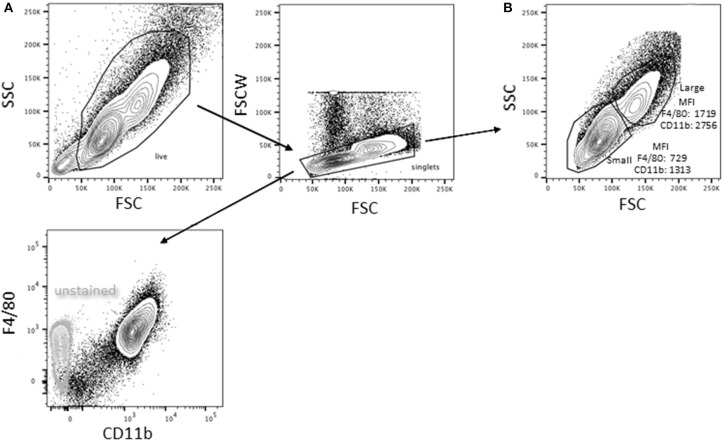
Bone marrow-derived macrophages exist as two distinct populations. Bone marrow was extracted and differentiated in L cell media as described in Methods. Adherent cells were collected 7 days post-harvesting and analyzed by flow cytometry (representative of BMDMs from 10 animals). (A) Virtually all (98 ± 2%) of the live singlets were CD11b+F4/80+. (B) After gating out dead cells/debris and selecting for singlets, two populations were identified: a minor (15.8 ± 3.4%) population of high forward and side scatter (large) cells and a major population that is smaller with lower side scatter. The large population had significantly higher expression of both F4/80 and CD11b (p < 0.01, n = 10, paired t-test).